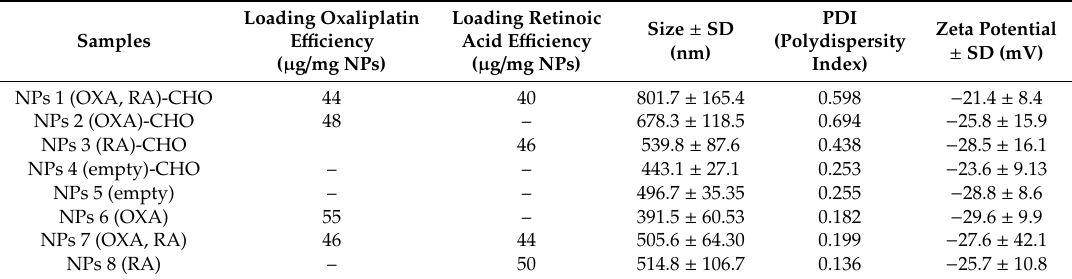
Table 1. Physicochemical properties of Poly(D,L-Lactide-co-Glycolic Acid) (PLGA) nanoparticles (NPs). Determination of retinoic acid (RA) and oxaliplatin (OXA) content, size distribution, and zeta-potential of PLGA NPs. Particles were characterized by Dynamic Light Scattering (DLS) and zeta-potential measurements. Particle size data represent the mean value ± standard deviation (SD) of dynamic light scattering data. Zeta-potential data represent the mean value ± SD of 10 readings. OXA and RA contents of PLGA NPs were determined by particle digestion and measured by reversed-phase high-performance liquid chromatography (RP-HPLC)